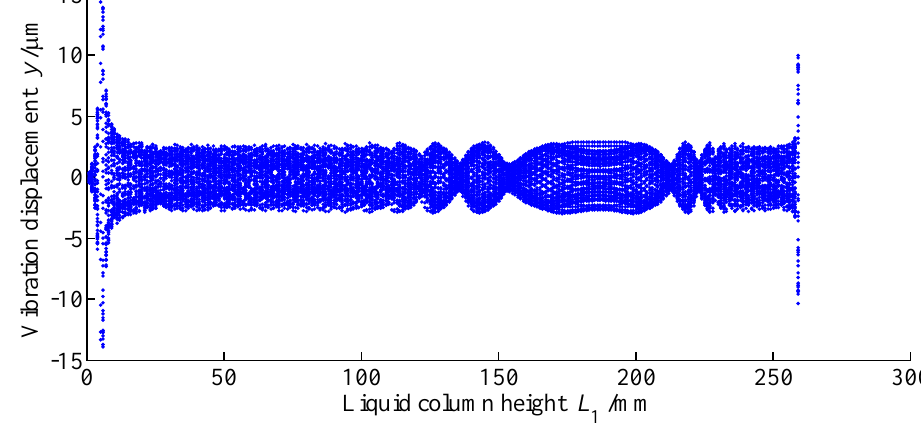
L . Figure 7. Bifurcation diagram with the variation of L 1 1